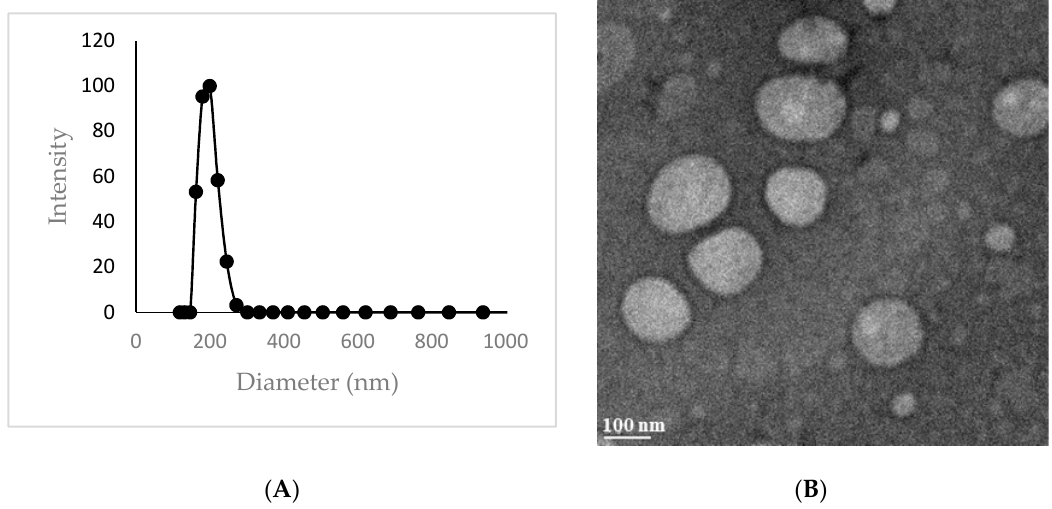
Figure 3. ( A ) Dynamic light scattering (DLS) size distribution and ( B ) transmission electron microscopy (TEM) image for the aqueous assemblies of isoxazole telodenderimer. The concentration of the polymeric micelle solution was 2 mg/mL for TEM study.